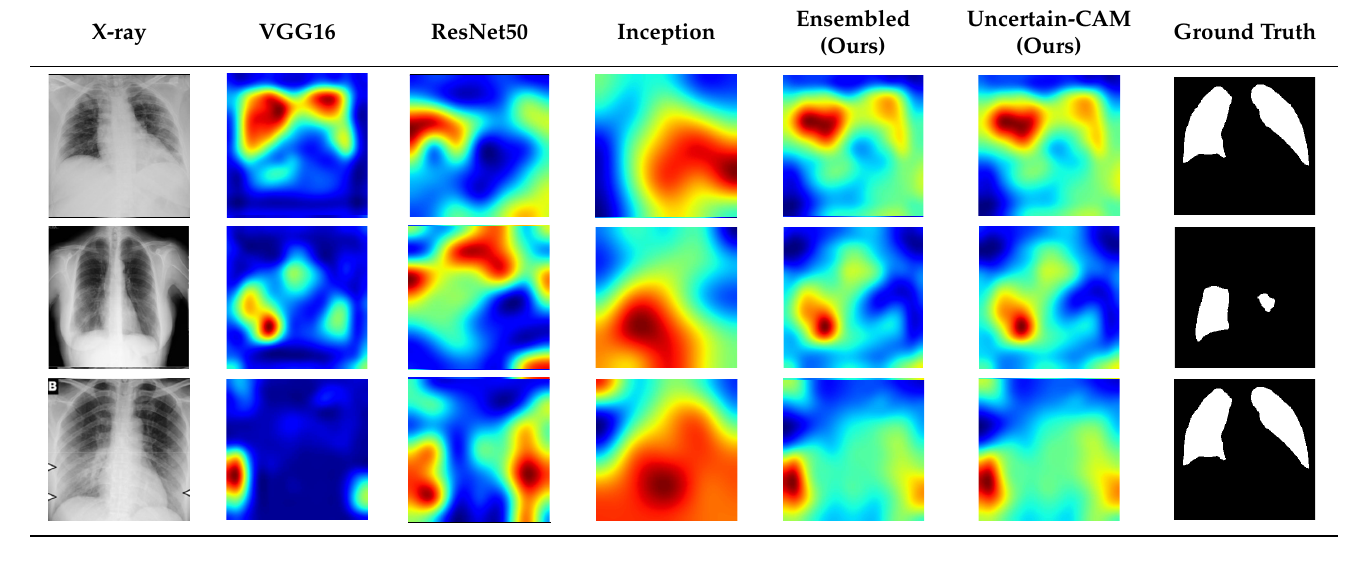
Table 6. Explainability of positive COVID-19 X-ray classified as positive.